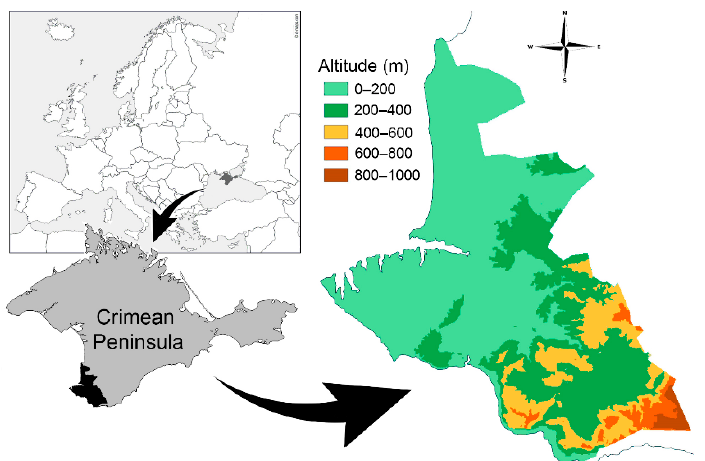
Figure 1. Geographical location and altitude distribution in the Sevastopol region.